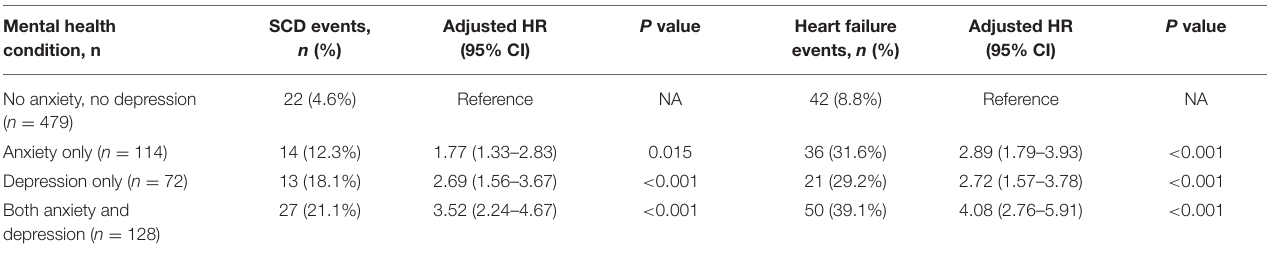
TABLE 5 | Multivariable analyses for the association between anxiety and depression and the risk of SCD events and HCM-related heart failure